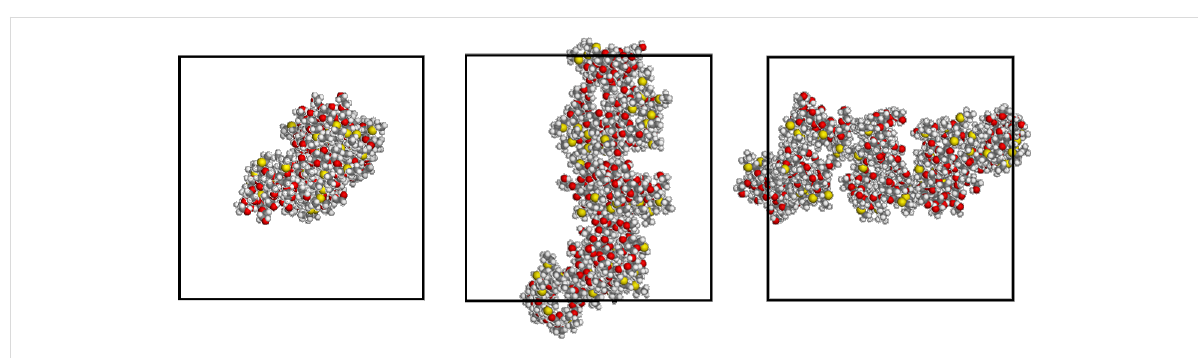
Figure 2: The aggregate of eight molecules of the aCD of Scheme 1 with n = 0, obtained from the second trial random arrangement of eight mole- cules in a periodic cell after the MD run of 100 ns. The three projections are taken along the cell z -axis, the y -axis, and the x -axis from left to